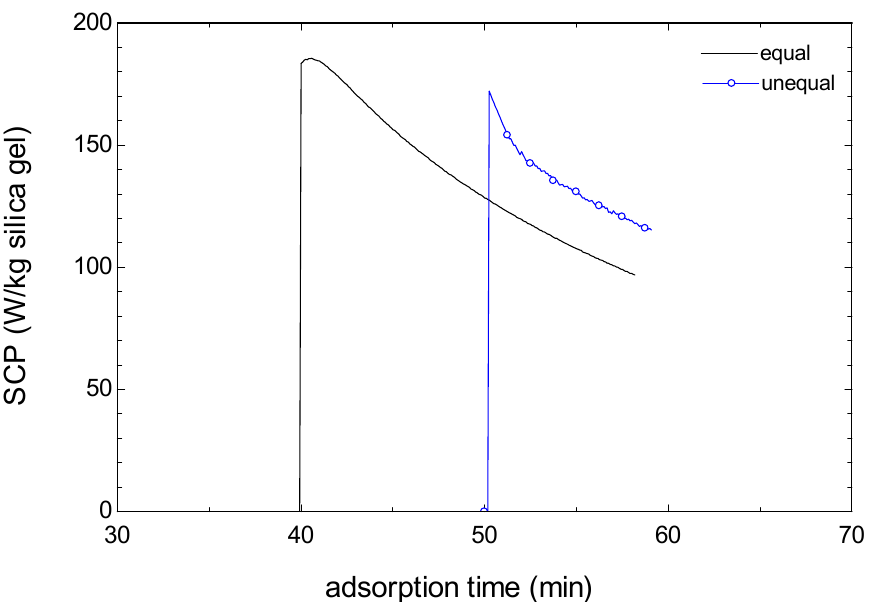
Figure 9. Specific cooling capacity variation.